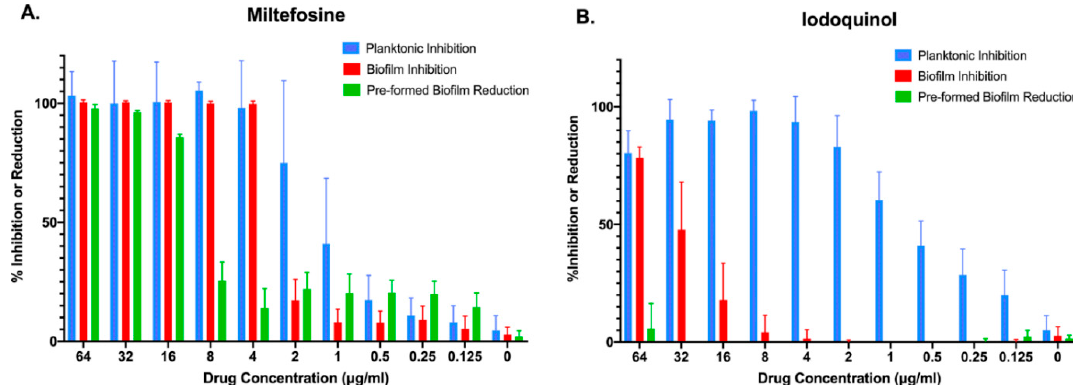
Figure 3. Activity of the two main repositionable compounds miltefosine and iodoquinol against C. auris strain 0390, under the three different growing conditions: inhibition of planktonic growth (blue bars), inhibition of biofilm formation (red bars), and activity against preformed biofilms (green bars).